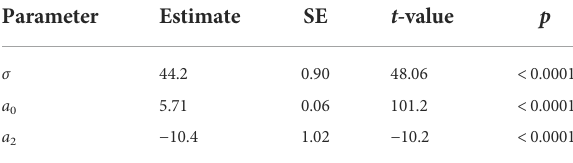
TABLE 2 Fitted parameter values and summary statistics of Eq. 2, with the effect of passing side (  ) set to zero ( a 1 = 0).